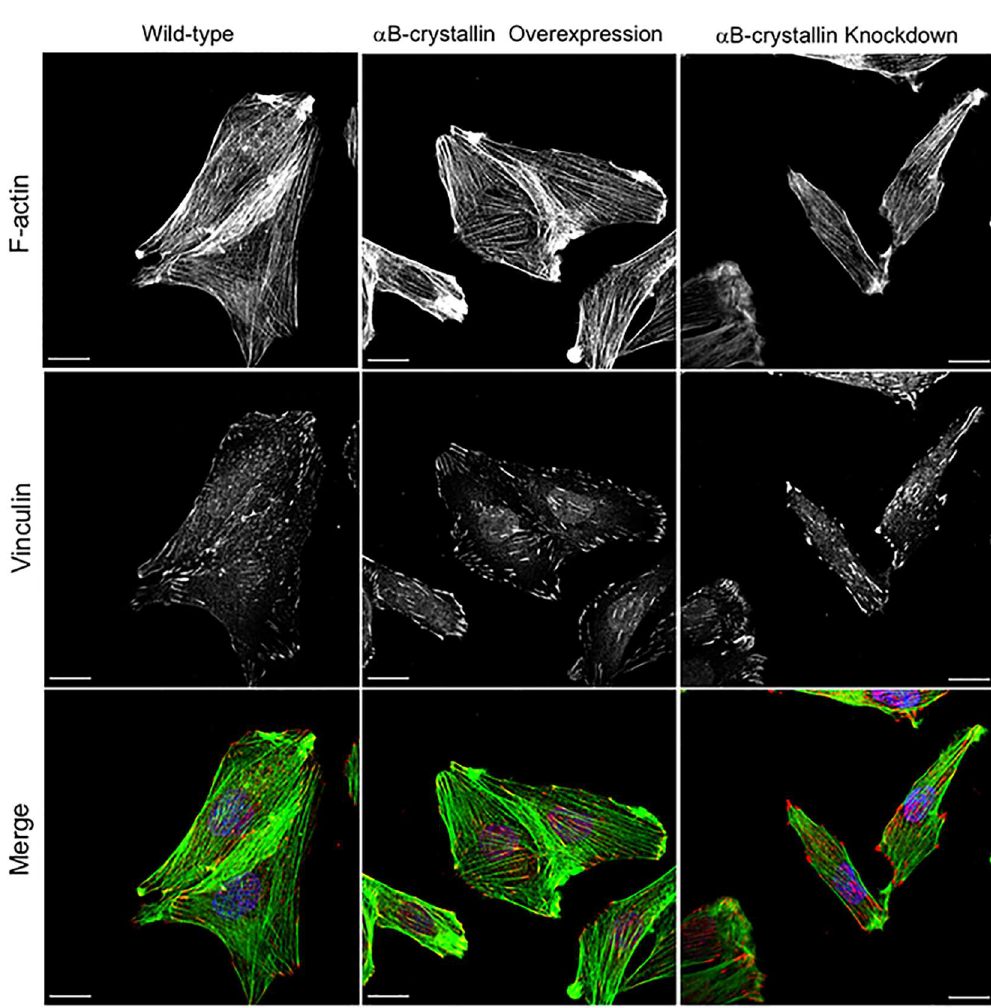
Fig 11. Focal adhesion-stress fiber phenotype is α B-crystallin dependent. Wild-type, α B-crystallin overexpressed, and knockdown L6 cells were visualizedfor F-actin (green), vinculin(red), and nucleus(blue). Bar is 20 μ